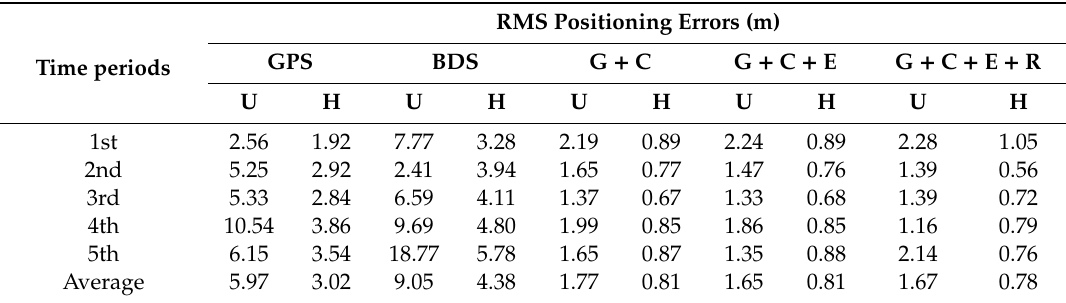
Table 4. The RMS positioning errors of the five time periods using di ff erent global navigation satellite systems (GNSS) system combinations. The “G”, “C”, “E” and “R” denote GPS, BDS, Galileo and GLONASS. The “U” and “H” denote “up” and “horizontal”.